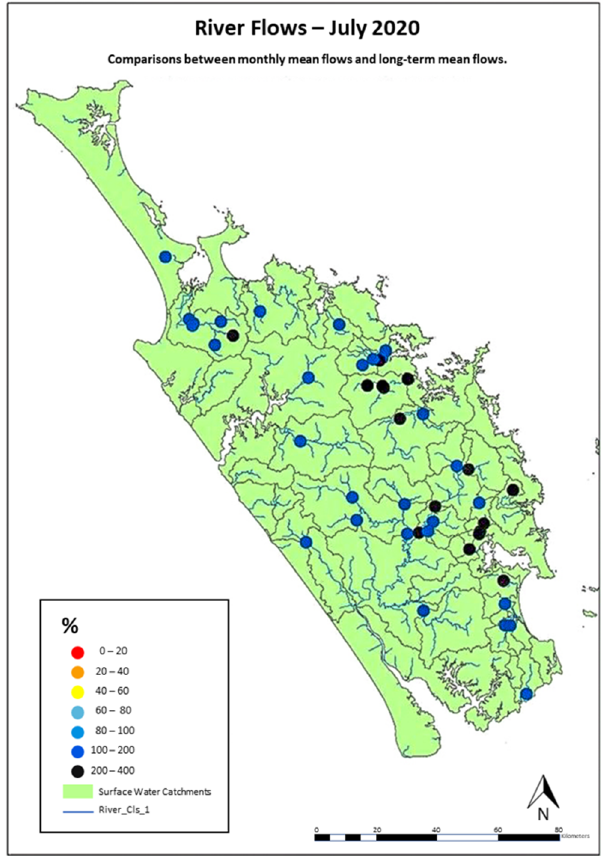
Figure 2. River flow map (Source: Northland Regional Council climate report 2020 [8]).